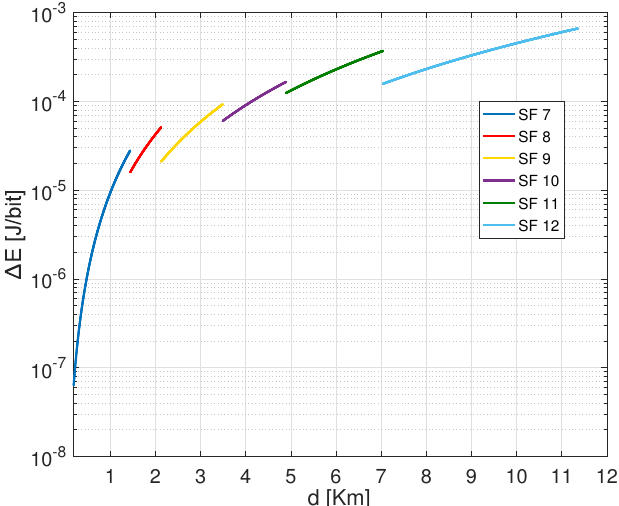
Figure 9. Optimum setting classifications for ranges d using different SFs with CR 4/8 to carry out 30 Bytes payload.